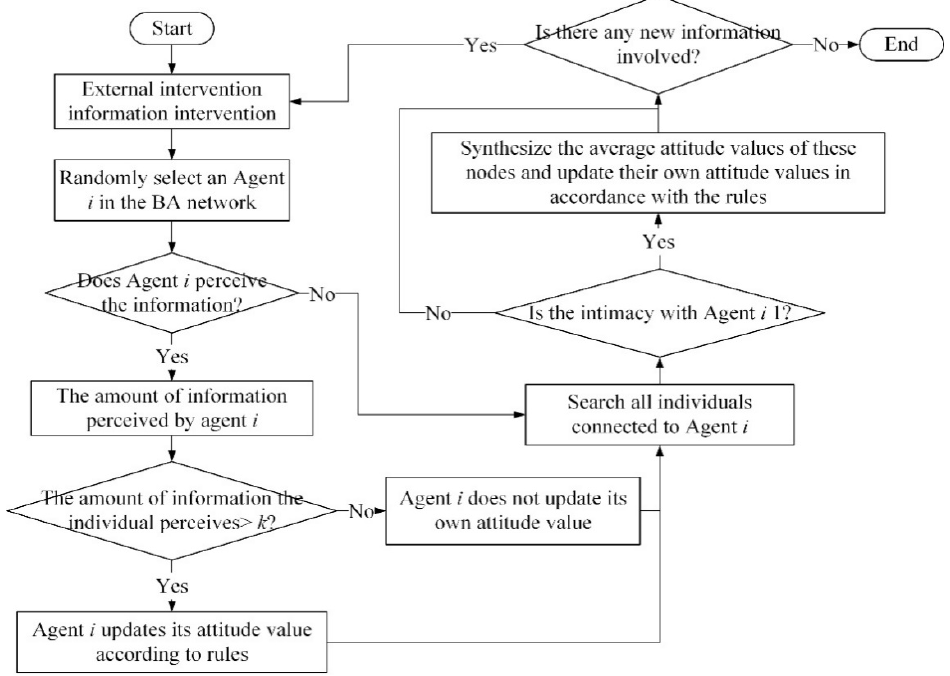
Figure 4. Simulation diagram based on the multi-agent method proposed by Monte Carlo.